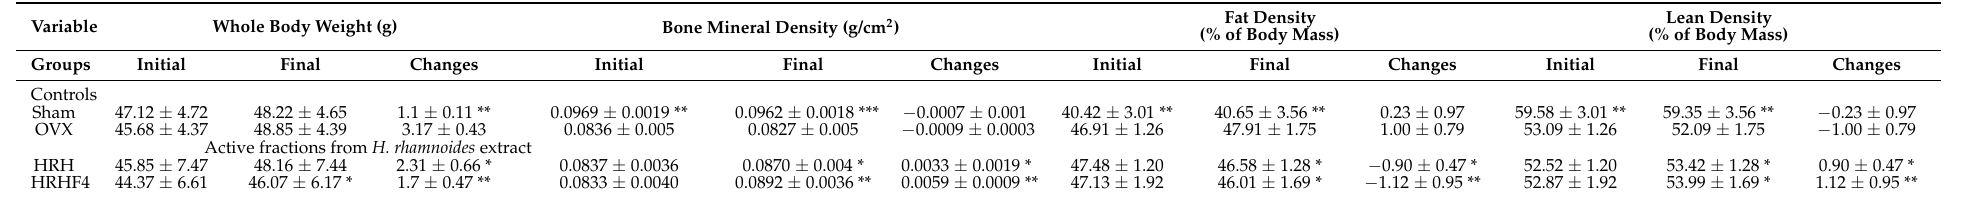
Table 1. Whole body weight, bone mineral density, body fat, and lean density changes of each mouse